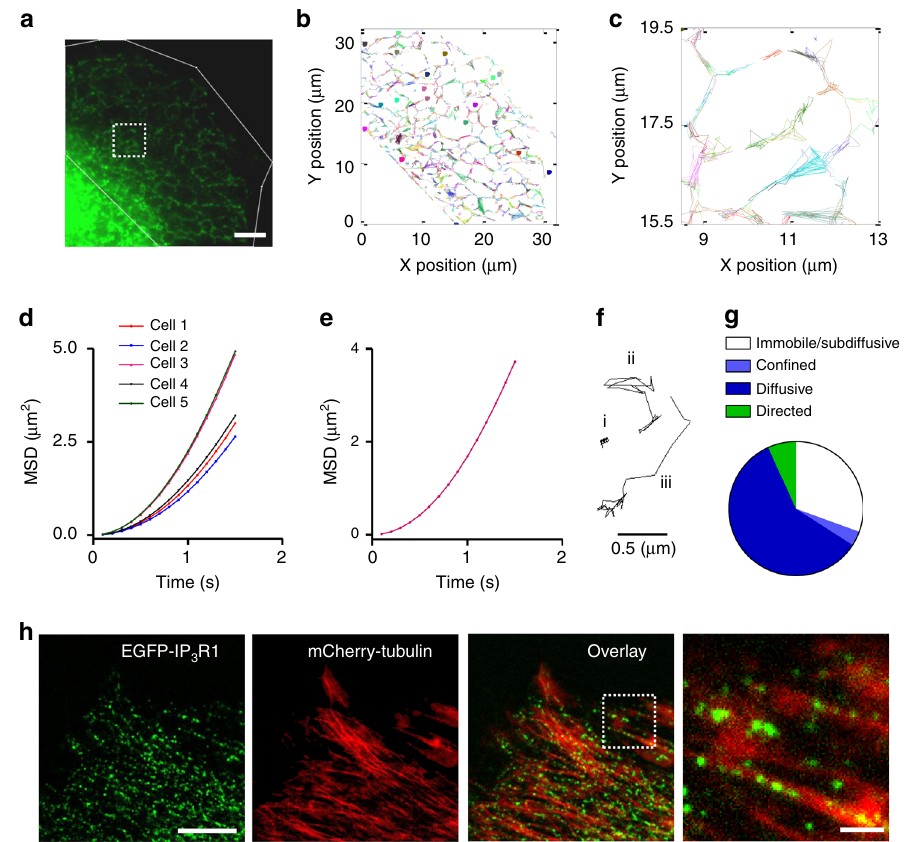
Fig. 5 IP 3 Rs move by diffusion and by directed motion along microtubules. a TIRFM image used for single-particle tracking shows characteristic reticular ER. Scale bar = 5 µ m. b Trajectories of all puncta from the region de fi ned by white lines in a . Colours indicate different trajectories. c Enlargement showing trajectories within the boxed area in a . d Average mean squared displacement (MSD) for all puncta within each cell plotted against time. Results are from fi ve cells, with 225 – 926 puncta analysed in each. e Pooled results from fi ve cells (2,698 tracks). f Examples of single-particle trajectories (collected at 100-ms intervals) for an immobile punctum (i) or mobile puncta moving by diffusion (ii) or directionally (iii). g Distribution of EGFP-IP 3 R1 puncta between mobility states. Trajectories of 1,509 puncta from fi ve cells were analyzed by TraJClassi fi er (Supplementary Fig. 10). h Wide- fi eld images, typical of nine cells, show EGFP-IP 3 R1 puncta, microtubules (mCherry-tubulin) and their co-localization. Final panel shows an enlargement of the boxed area in the overlay. Scale bar = 10 µ m (2 µ m in